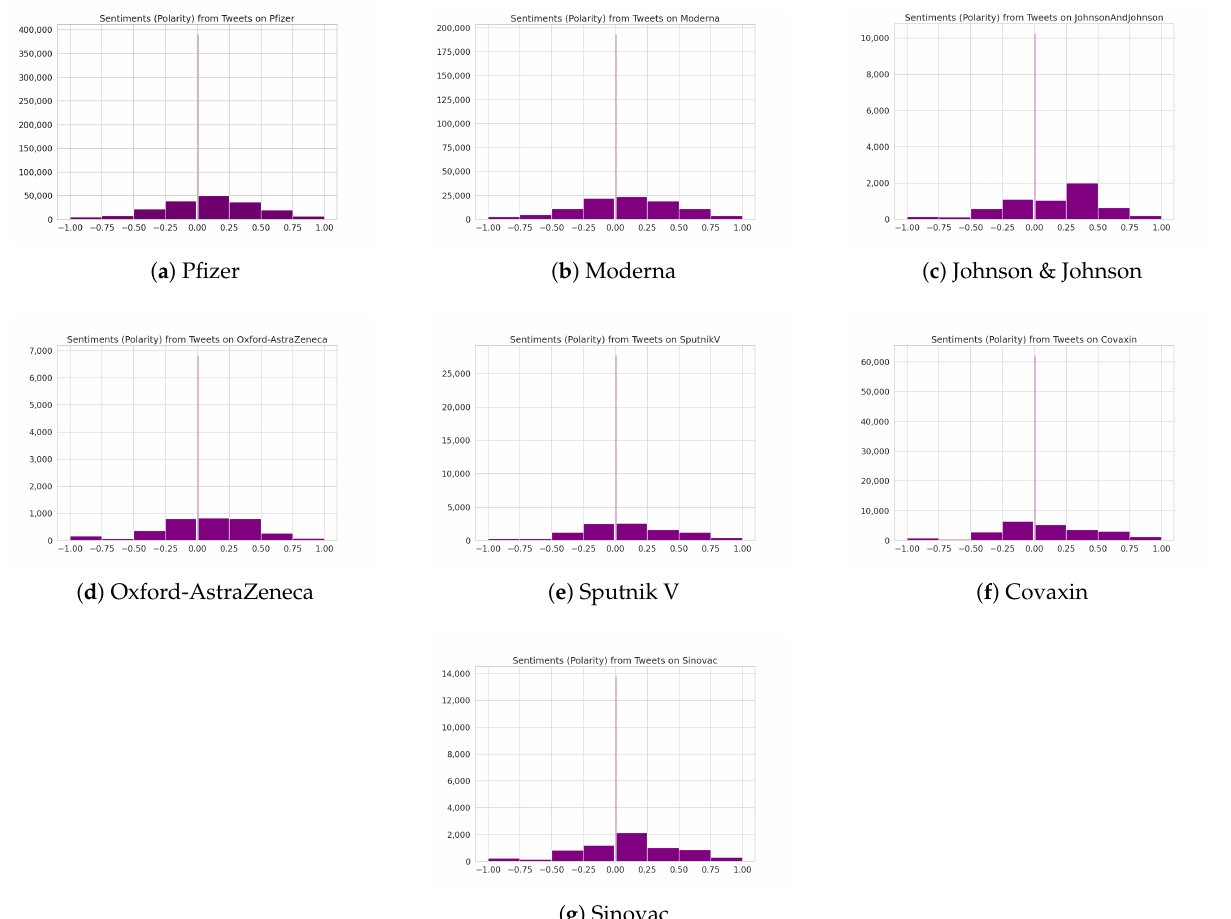
Figure A1. Polarity Score of Sentiment for Different Vaccines.